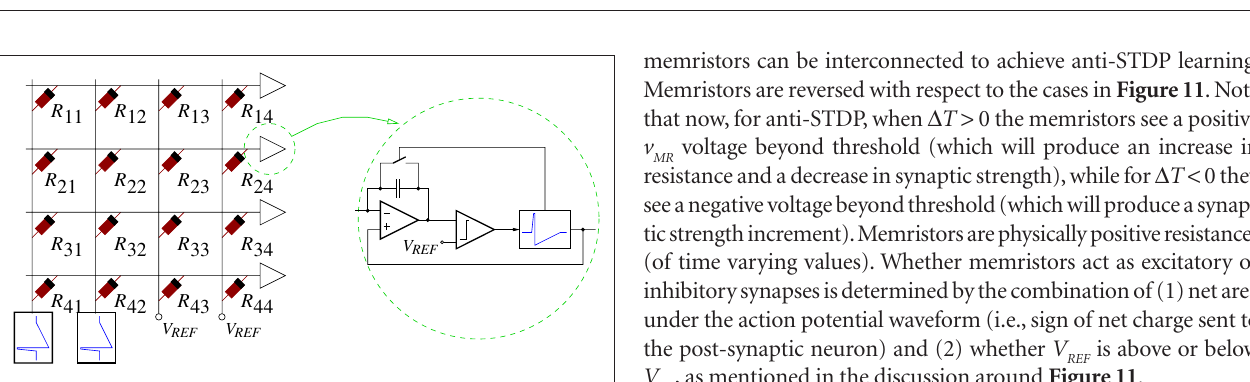
Figure 11 | Two possible interconnection schemes between memristors and neurons for STDP learning. (A) Memristor polarities for spikes as in Figure 8A . (B) Memristor polarities for inverted spikes as in Figure 8B .